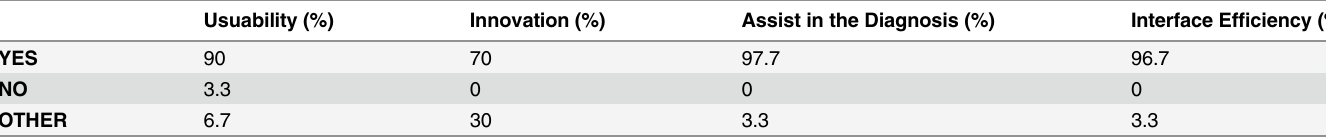
Table 6. Assessment of the different characteristics of